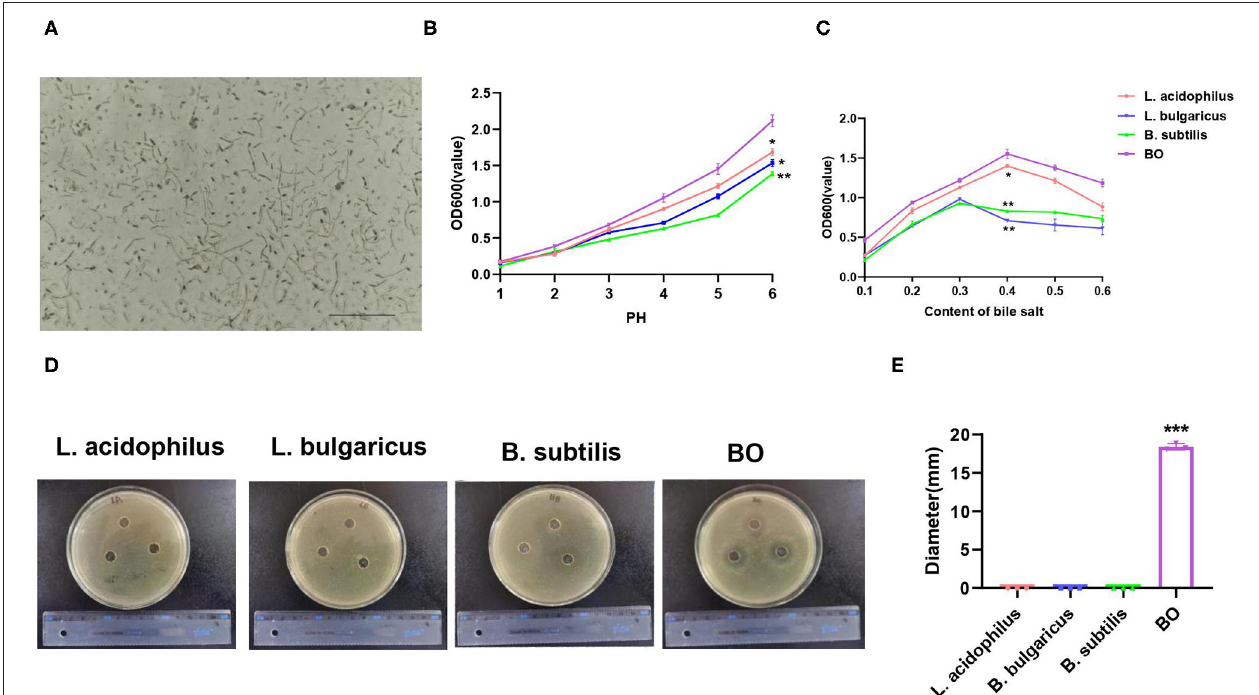
FIGURE 1 | The morphological and probiotic characteristics of Bornlisy (BO). (A) The morphological characteristics of BO were observed under a light microscope (scale bar, 250 µ m). (B) The single strain and fermentation mixture were inoculated in the specific liquid medium at different pH and were cultured at 37 ◦ C for 3h at 100 r/min, and optical density (OD) 600 was measured by spectrophotometer. (C) The single strain and fermentation mixture were inoculated in the specific liquid medium containing different concentrations of bovine bile salt and were cultured at 37 ◦ C for 3h at 100 r/min, and their OD 600 were measured by spectrophotometer. (D) Escherichia coli was inoculated on LB solid medium for the night at 37 ◦ C for 12h. The representative images of the inhibition zone were shown. (E) The diameter of the inhibition zone was measured. Data with error bars are presented as mean ± SD. Each panel is a representative experiment of at least three independent biological replicates. * P < 0.05, ** P < 0.01, and *** p < 0.001 as determined by unpaired Student’s t